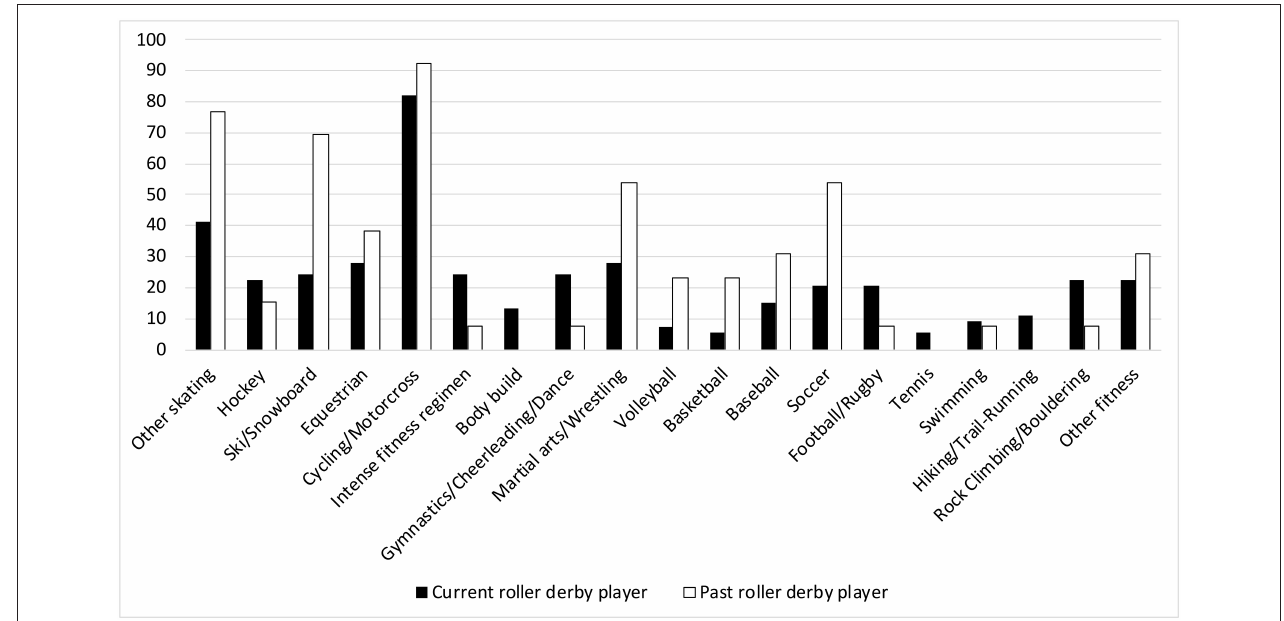
FIGURE 1 | Sport participation outside of roller derby per 1,000 athletes. Other skating: skatepark users, bowl skating, and ice skating. Intense fitness regimens: Tough Mudder, Spartan Races, CrossFit, etc. Other fitness: golf, field hockey, lacrosse, surfing, Quidditch, contact Live Action Role Play (LARPing), kayak polo, ultimate frisbee, paintball,